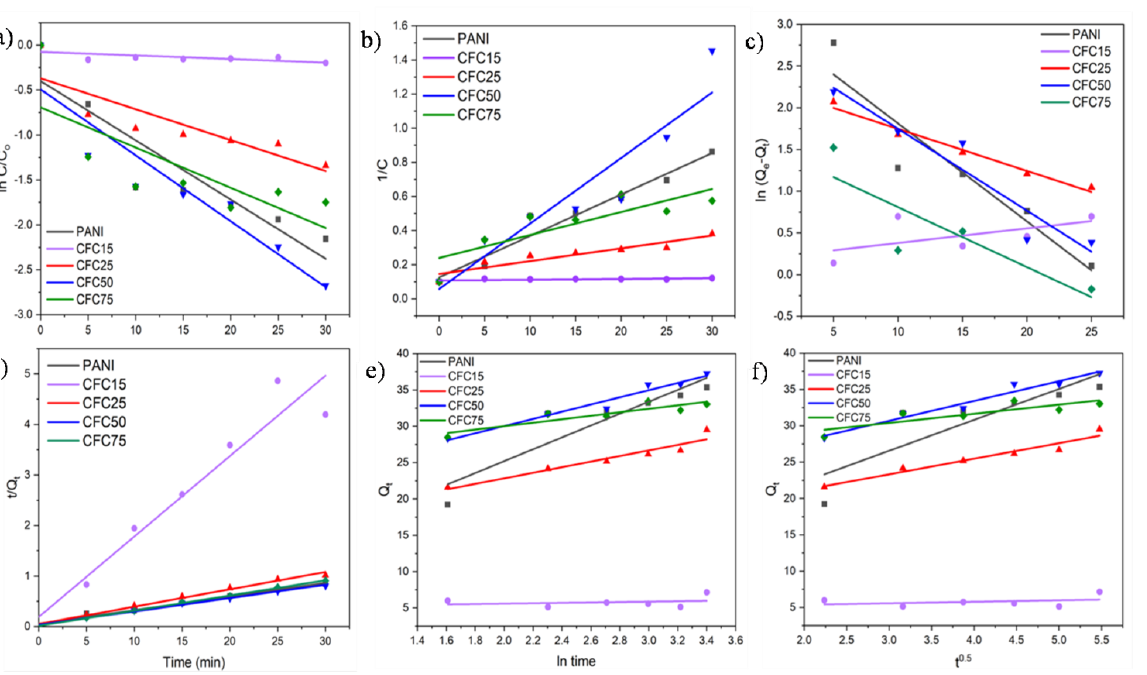
Figure 4. Kinetic models for the adsorption of Cr(VI) onto the prepared samples ( a ) First order, ( b ) Second order, ( c ) Pseudo first order, ( d ) Pseudo second order, ( e ) Elovich, ( f ) Intra-particle diffusion, (pH = 6, adsorbent dosage = 0.25 mg/mL, Cr concentration = 10 ppm, total contact time = 30 min).